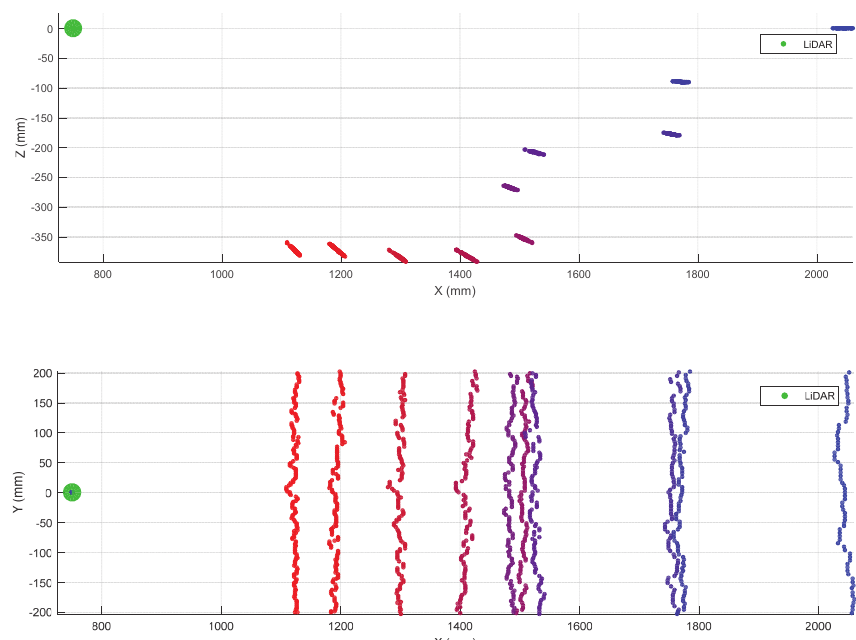
Figure 6. Top (up) and lateral (down) view of the different scans obtained when having stairs going up at a fixed distance of 750 mm in front of the 2D LIDAR depending on tilt angle. The tilt of the LIDAR has been changed from 0° (horizontal) to 45° in increments of 5°. The distance points originated by the surrounding walls have been eliminated for enhanced visual interpretation.